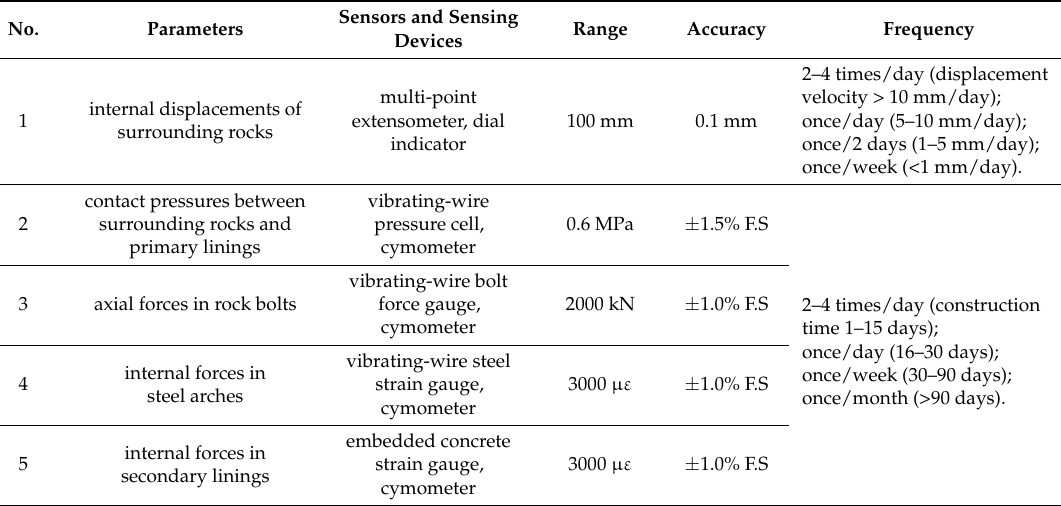
Figure 7. Layouts of the concrete strain gauges. Table 4. Monitoring parameters and methods.